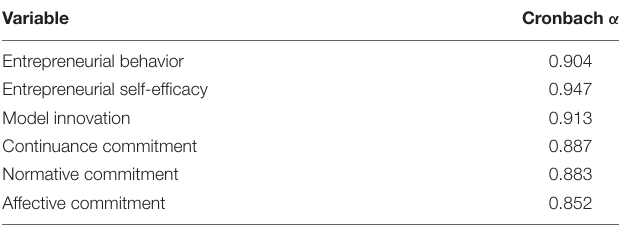
TABLE 3 | Reliability test results.